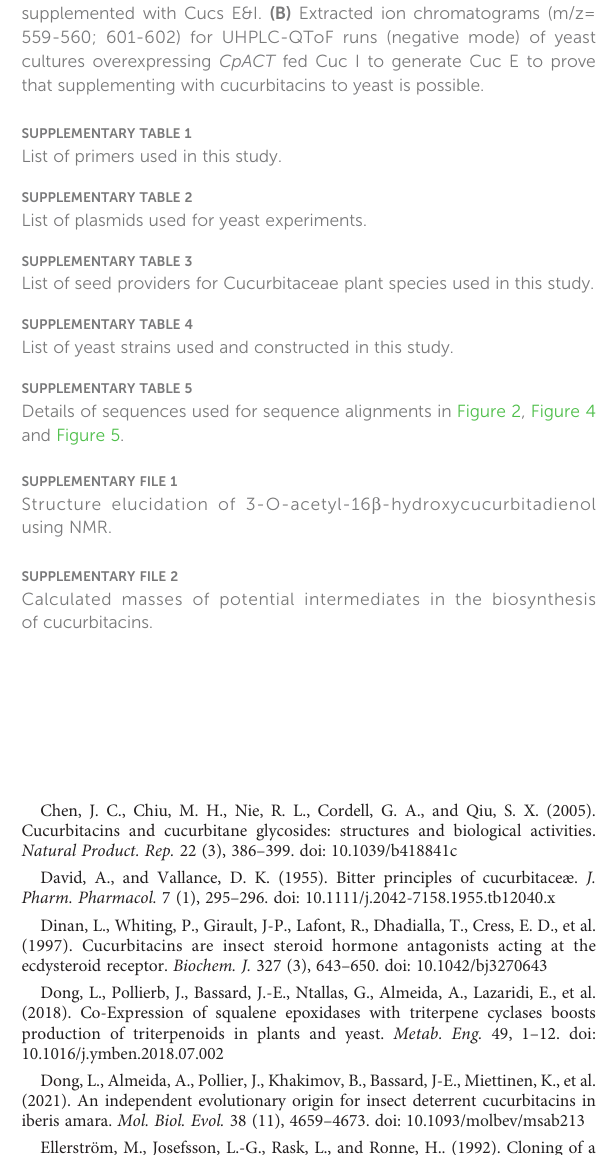
SUPPLEMENTARY FIGURE 7 The m/z ion 513.2452 is unique to transgenic hairy roots of squash overexpressing either CYP88L2 or CYP88L7 . (A) Extracted ion chromatogram (m/z= 513-513.5) for UHPLC-QToF analysis (negative mode) for EV and CYP88L2 or CYP88L7 overexpressing hairy roots. (B) Possible cucurbitacin structures for an ion of m/z= 513-513.5 with